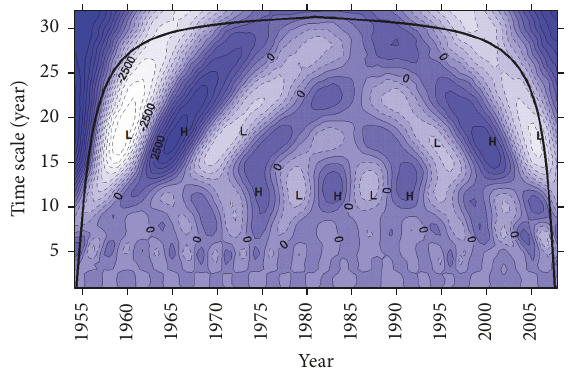
Figure 4: The contour of the real part of Morlet wavelet coefficients in YC station.